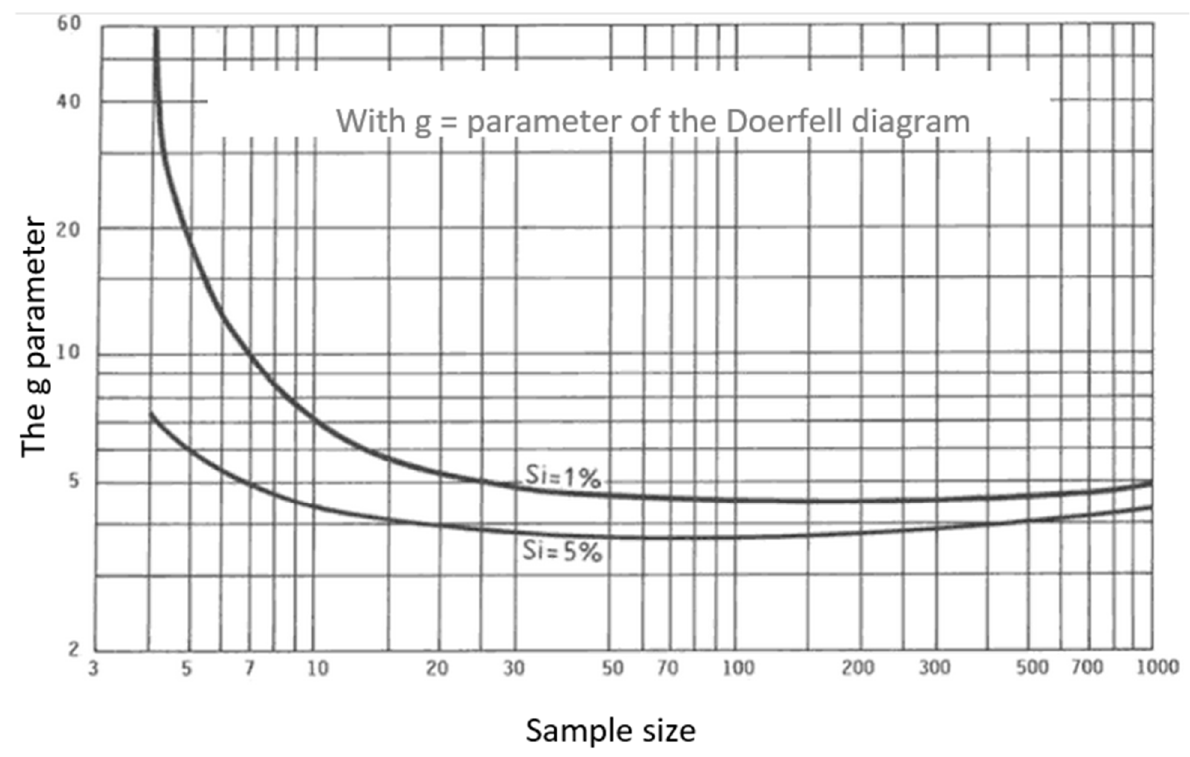
Figure 5. Doerffel diagram for determination of outlier threshold [16].